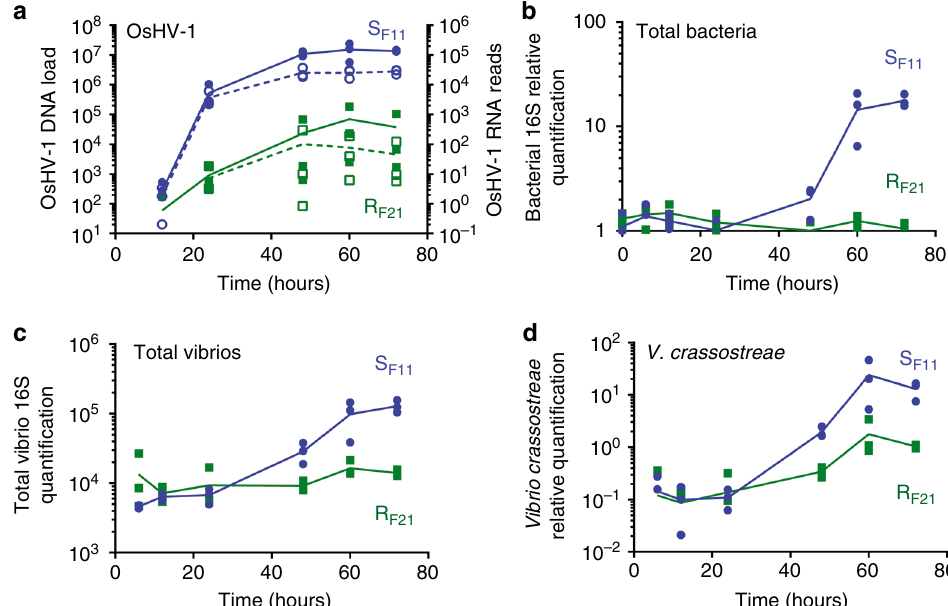
Fig. 2 OsHV-1 and bacterial colonization in the susceptible S F11 oysters during the ‘ natural ’ experimental infection. a The OsHV-1 load was quanti fi ed by qPCR and expressed as viral genomic units per ng of oyster DNA (plain lines, fi lled symbols); viral replication was estimated by the total number of RNA-seq reads mapped on the OsHV-1 genome (dotted lines, open symbols). Relative quanti fi cation of total bacteria ( b ), total Vibrio load ( c ) and Vibrio crassostreae ( d ) abundance were measured by qPCR. Dots represent distinct pools of 10 oysters. The mean values (plain and dotted lines) are